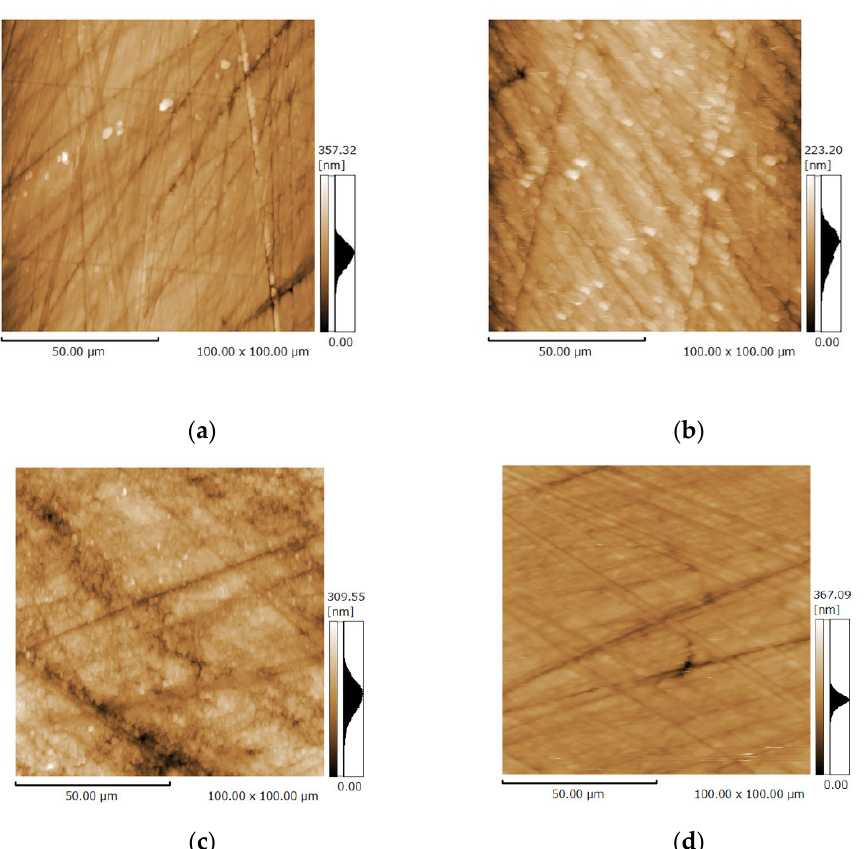
Figure 5. Scanning probe microscopy micrograph of the specimen: ( a ) polished bovine enamel; ( b ) polished hydroxyapatite coating on the specimen; ( c ) bovine enamel after brushing test; ( d ) hydrox ‐ yapatite coating after brushing test.